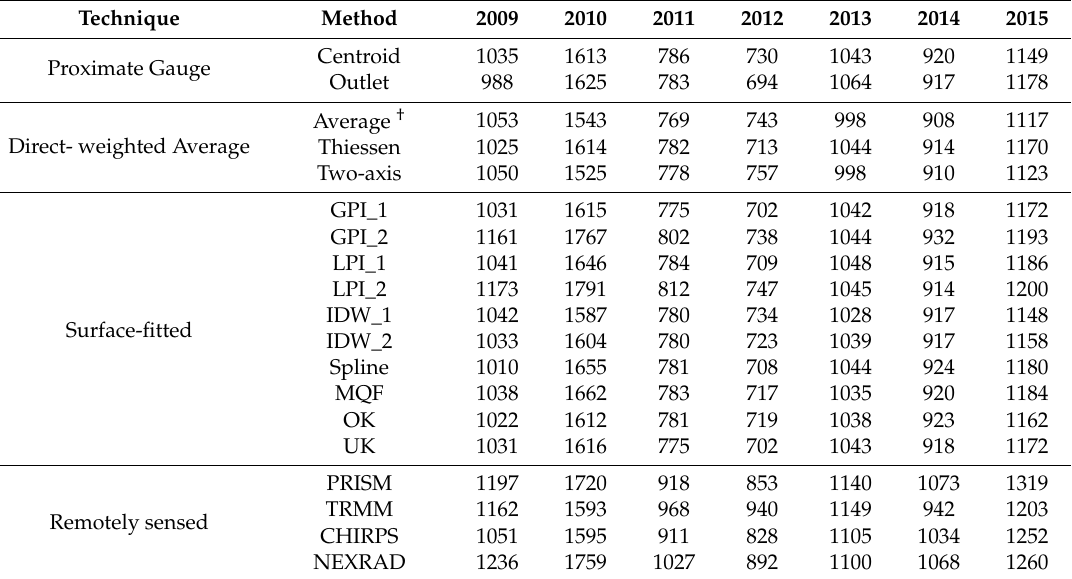
Table 5. Five-site average annual mean areal precipitation (mm) estimated using 19 methods during the water years from 2009 to 2015 in Boone County, Missouri, USA.